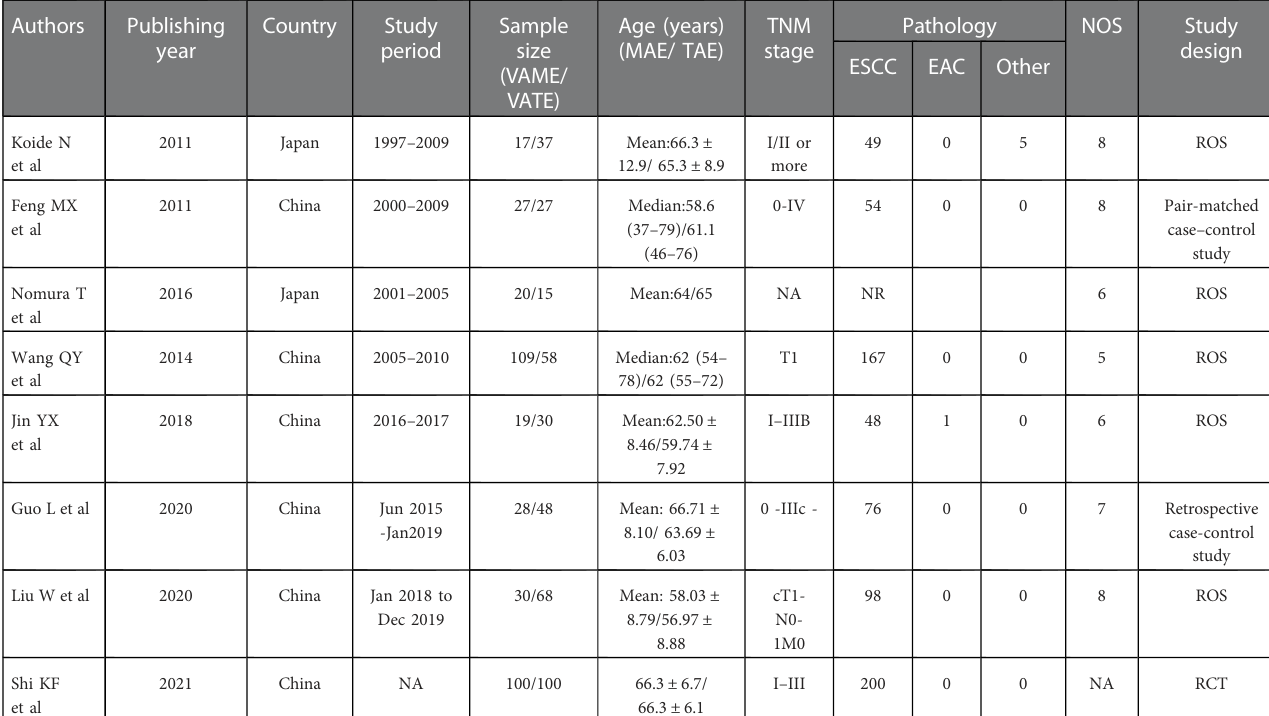
TABLE 1 Basic characteristics of included studies.